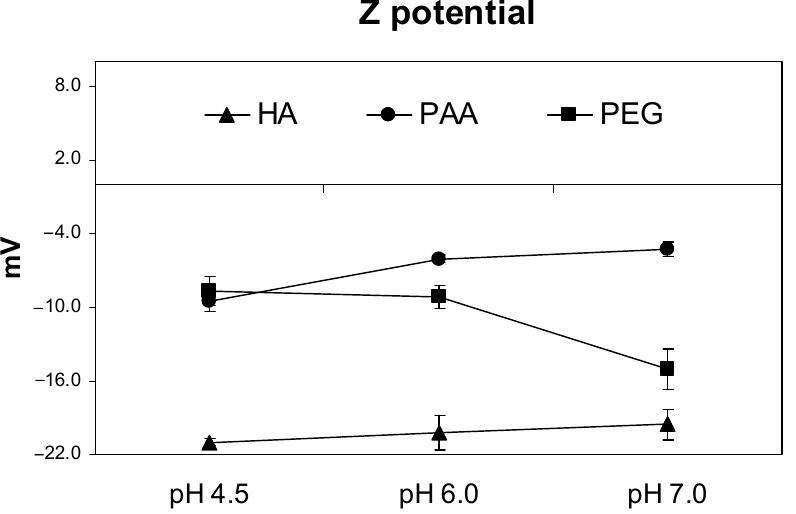
Figure 1. Evolution at different pH of Z potential for PEG, PAA, and HA at work concentration solutions. The measurements correspond to the mean value ( n = 3) ± standard deviation.